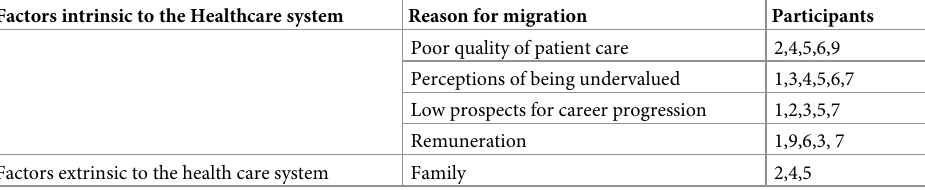
Table 2. Main influencers of